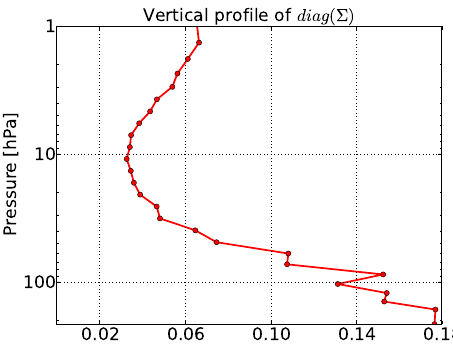
Figure 1. Vertical profile of the background error as used for the Fig.1:Verticalprofileofthebackgrounderrorasusedforthestandarddeviationmatrix Σ . standard deviation matrix 6